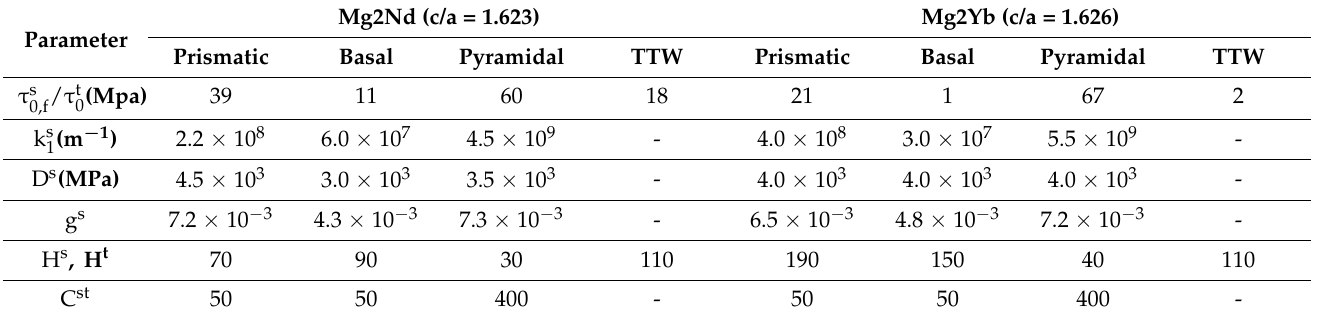
Table 3. Hardening parameters for slip and twin